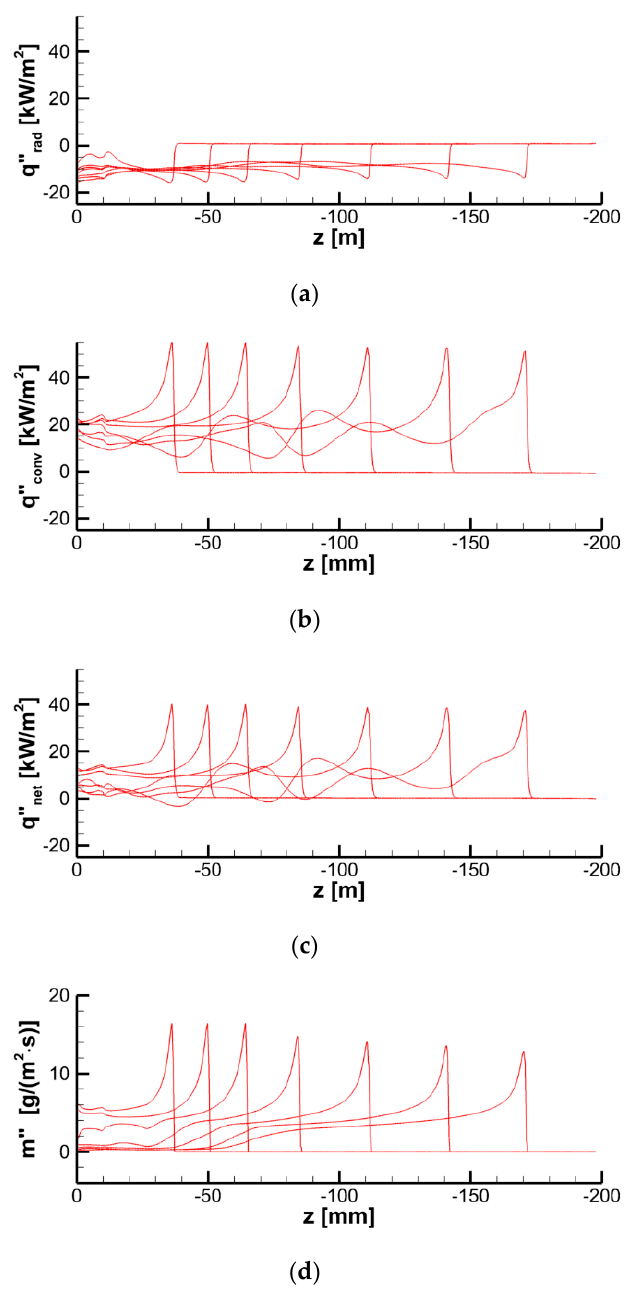
Figure 26. Distributions of radiative ( a ), convective ( b ), and net ( c ) heat fluxes and mass burning rate ( d ) at the specimen surface along the vertical centerline at time instants of 20, 40, 60, 80, 100, 120, and 140 s.